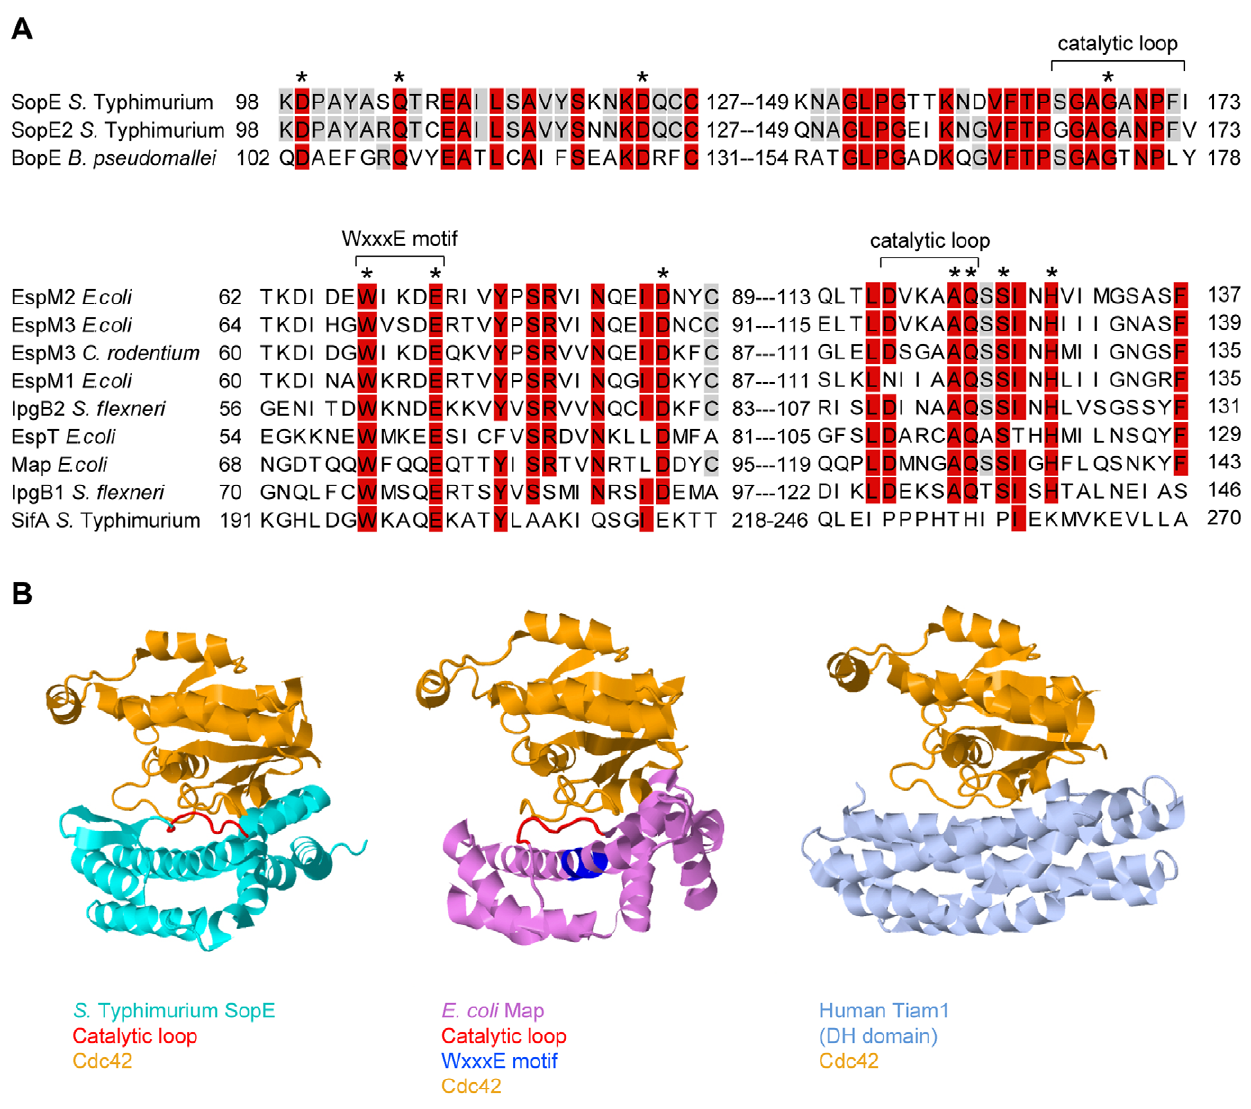
Figure 2. Sequence and structural comparison of GEFs from different origins. (A) Sequence alignment of SopE-type (upper alignment) and WxxxE-type (lower alignment) bacterial effector proteins with postulated Rho GTPase activity; . 80% identity is shaded in red, . 50% in grey. The residues shown to be important for catalytic GEF activity of SopE [13] or Map [19] are marked with asterisks. WxxxE motif and catalytic loops highlighted in (B) are marked with brackets. Note that SifA has a completely different amino acid sequence in its catalytic loop compared to the other proteins in the WxxxE family [19]. (B) Crystal structures of GEFs from different organisms in complex with Cdc42 (orange). Left panel: SopE (cyan) from S. Typhimurium [12]; the catalytic loop is highlighted in red. Middle panel: Map (pink) from enteropathogenic E. coli [19]; the WxxxE motif is highlighted in blue and the catalytic loop in red. Right panel: Human Tiam1 (pale blue); only the Rho GTPase binding DH domain is shown [14]. Structures were created using Jmol